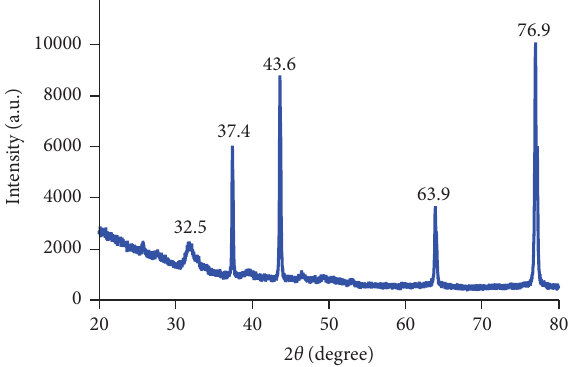
Figure 4: SEM (a) and EDS (b) of CQDs.